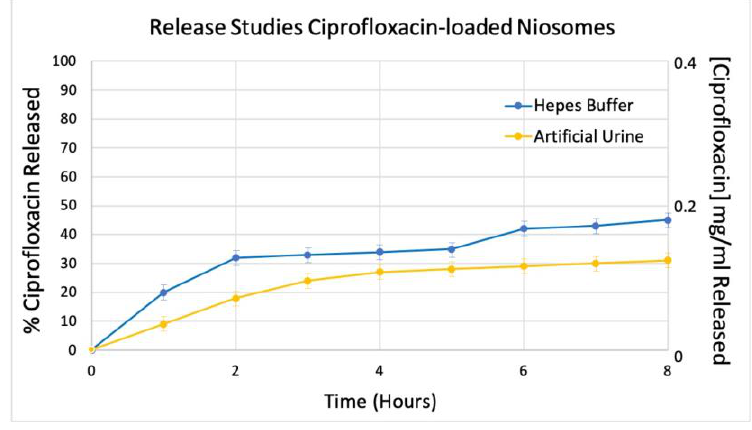
Figure 4. CIP release profile until up 24 h. Data were obtained as the mean of three independent experiments.